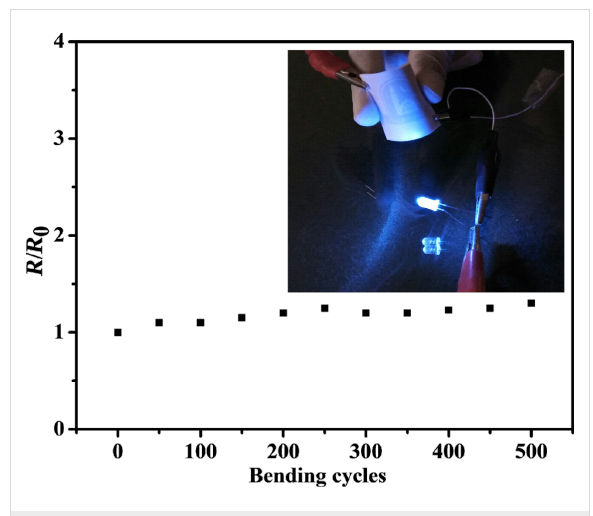
Figure 5: The bending test shows only little change in the sheet resis- tance of a AgNW-coated PET film after multiple bend–release cycles. The sheet resistance values of the PET film before and after bending test are represented by R 0 and R , respectively. The inset shows that the PET film bent by 90° is still